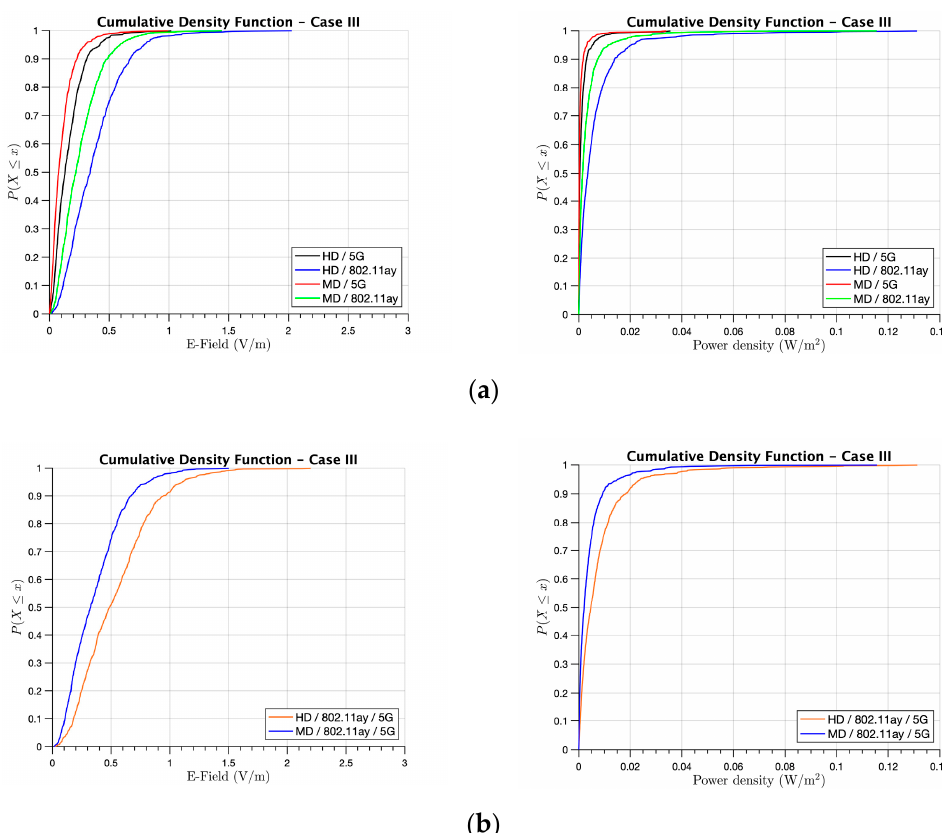
Figure 12. CDF of the received E-field and power density for Case III at the XY bi-dimensional plane at head height when the people were working on the first floor of the library: ( a ) 5G and 802.11ay comparison for HD and MD and ( b ) the total E-field exposure and power density for HD and MD.